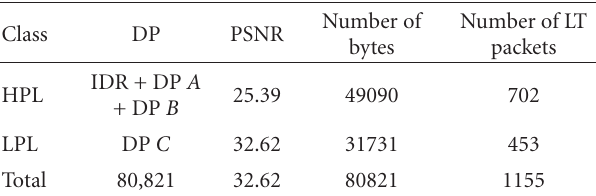
Table 3: Priority class and LT packetization for first GOP of “Football”